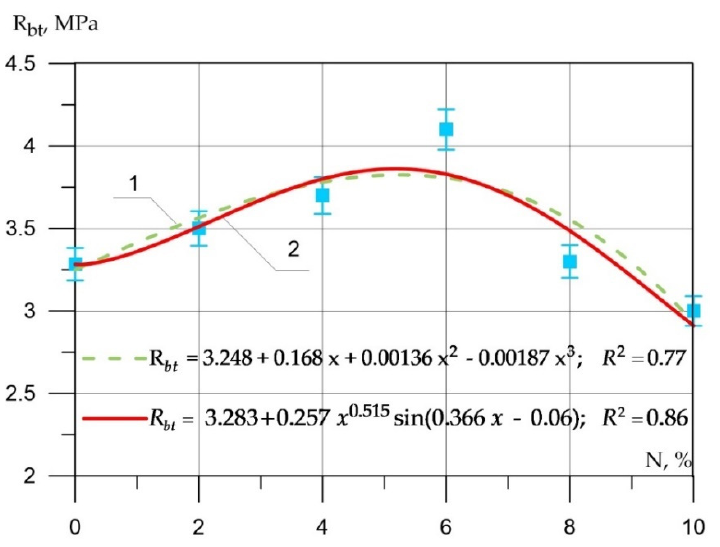
Figure 11. Results of experimental studies of the effect of dosage of rice straw biochar on axial tensile strength: 1—polynomial of the 3rd degree; 2—function (1).